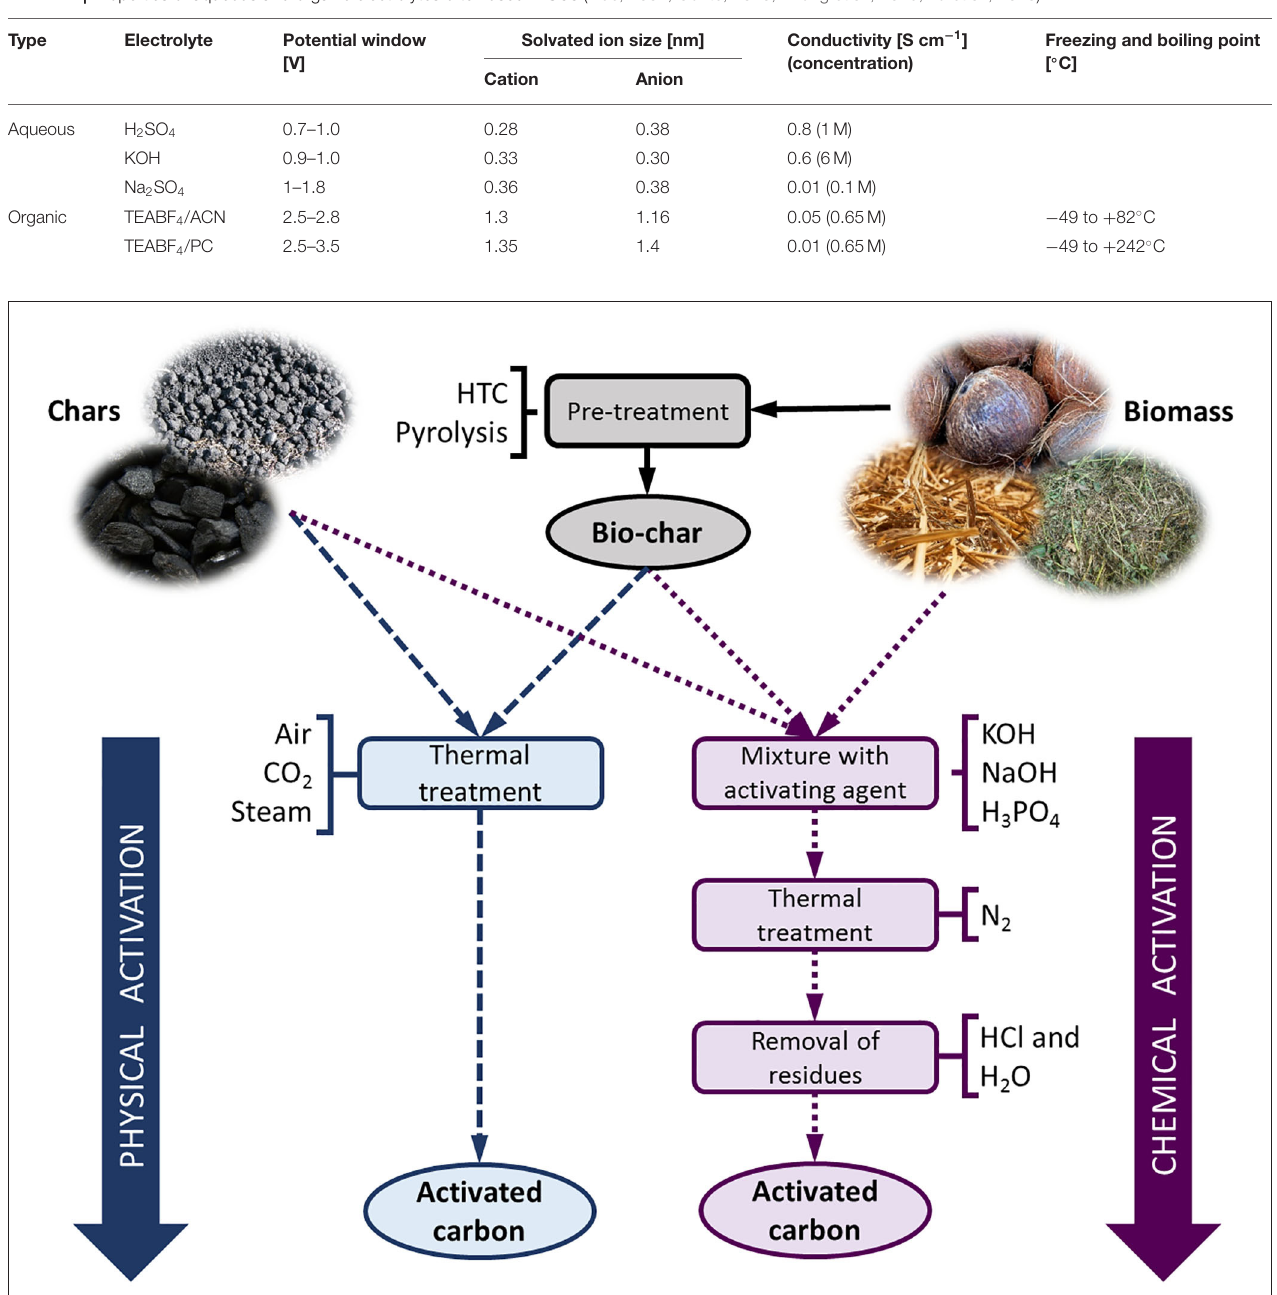
TABLE 1 | Properties of aqueous and organic electrolytes often used in SCs (Lide, 2004; Conte, 2010; Zhong et al., 2015; Lu et al., 2018).